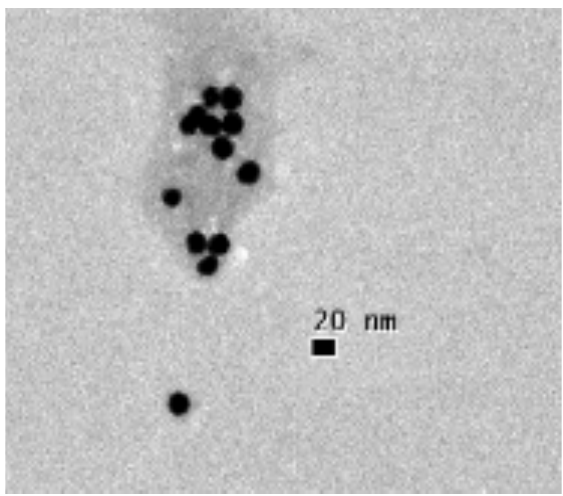
Figure 2. Transmission electron microscopy images of AuNP stabilized with TEM polymer. The scale bare is equal to 20 nm.